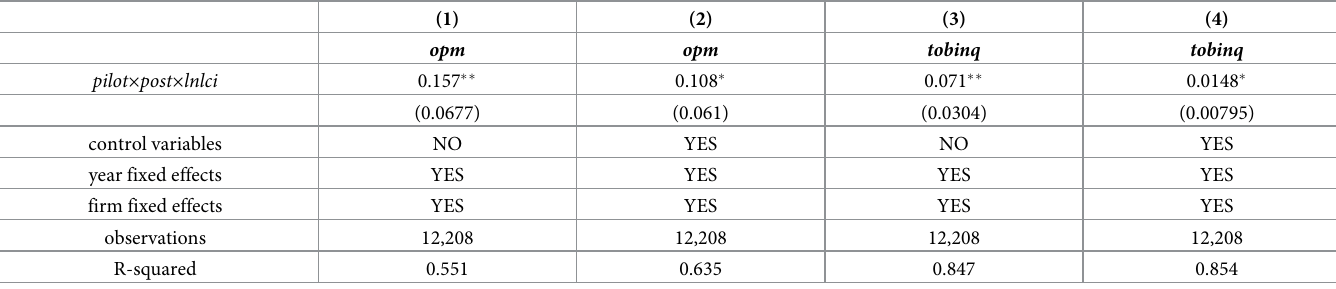
Table 7. Economic effects of low-carbon city pilot